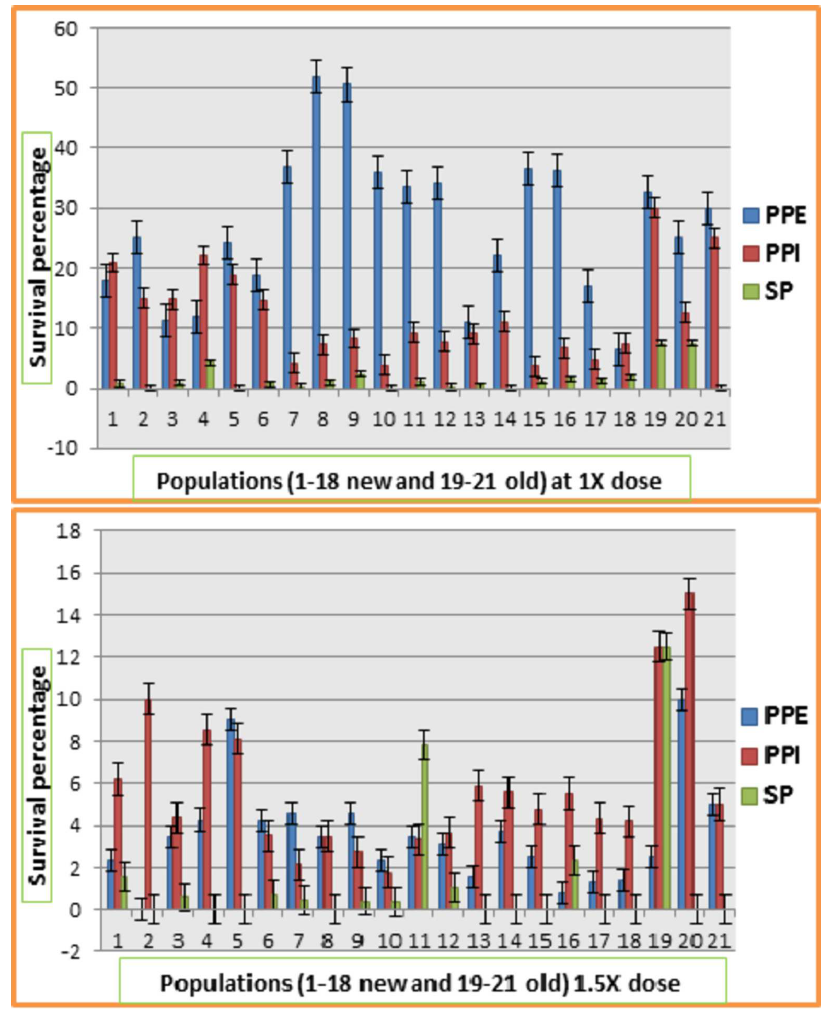
Fig 5. Response of 21 populations of lentil for survival percentage at different doses of Atlantis at three different screening